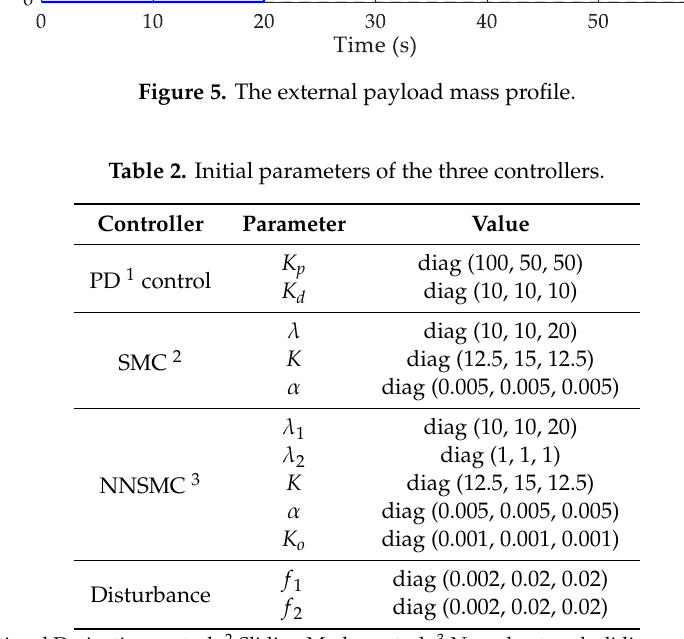
Figure 6. Comparison of tracking performance of the first joint: ( a ) tracking position, ( b ) tracking error.